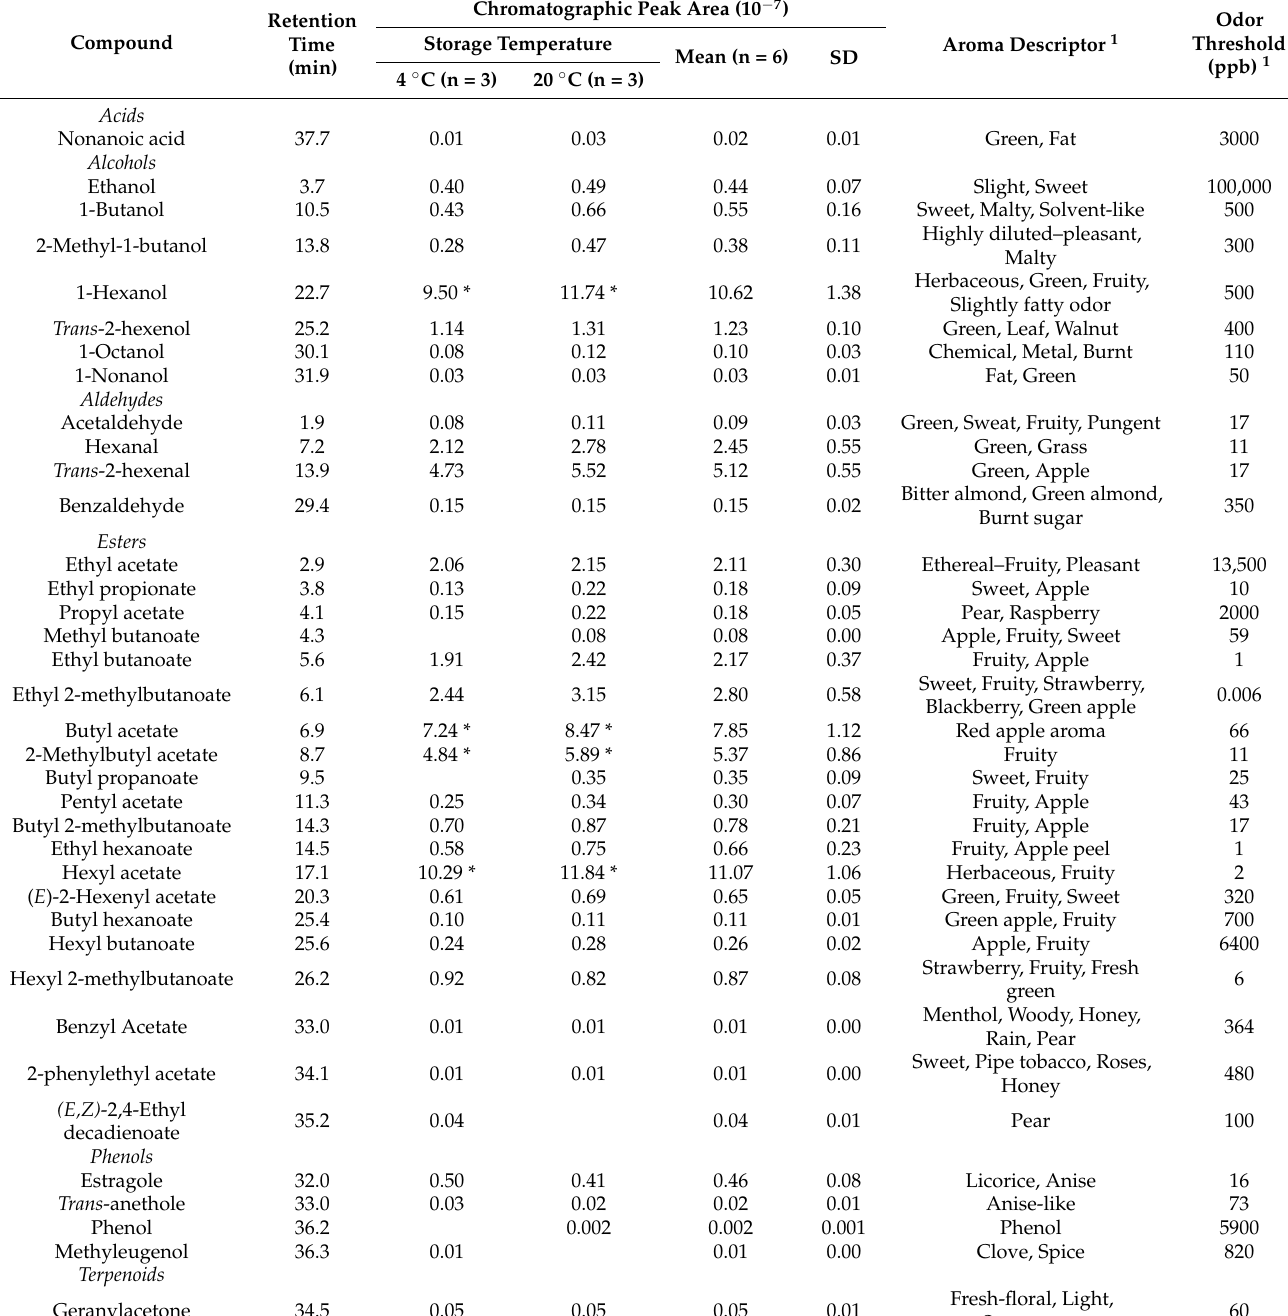
Table 1. Volatile composition of apple aroma stored at 4 ◦ C and room temperature, aroma descriptors, and odor threshold reported in